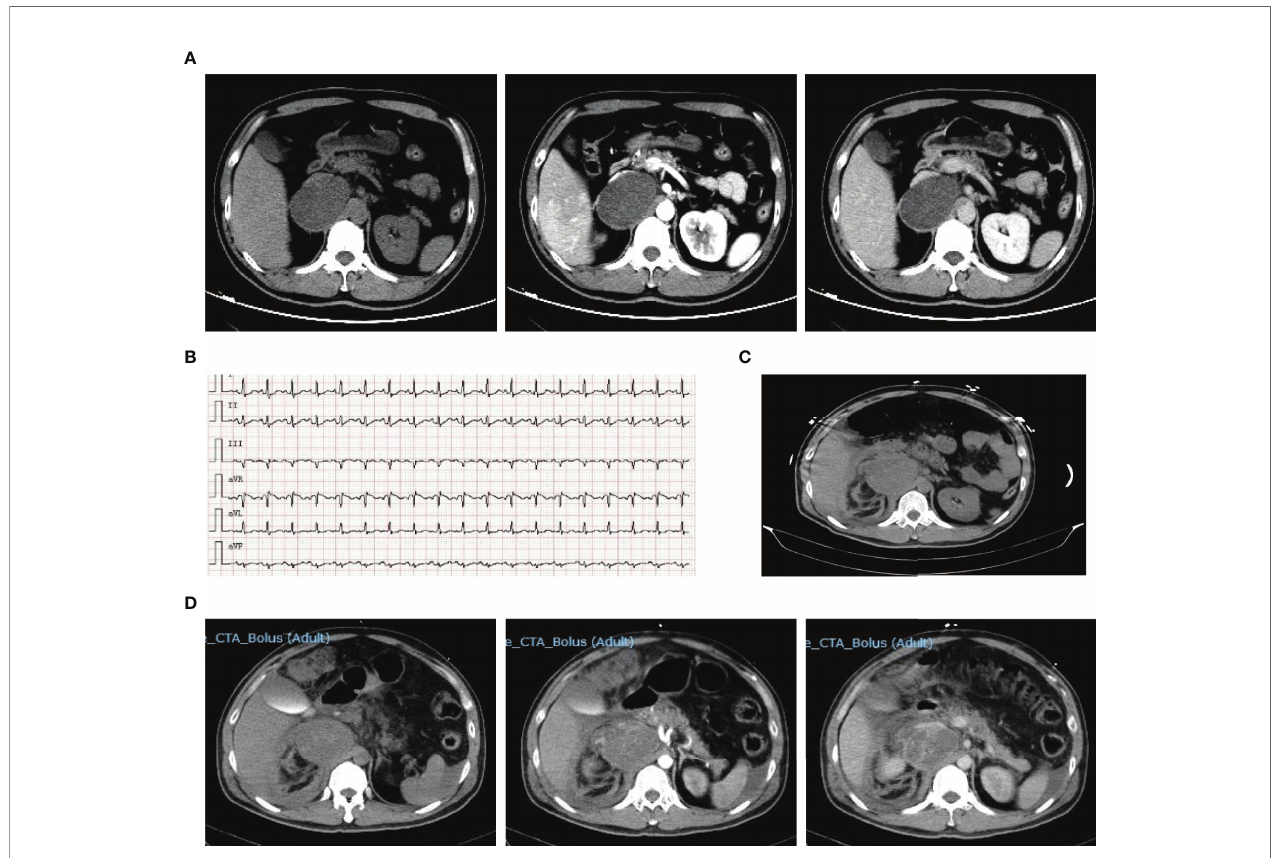
FIGURE 1 | Representative images of patient 1. Contrast-enhanced CT on admission showed right adrenal mass (A) . ECG on the 3 rd day showed tachycardia (B) . CT scan on the 3 rd day showed pheochromocytoma rupture and hemorrhage (C) . Reexamination enhanced CT showed retroperitoneal hematoma on the 4 th day (D)